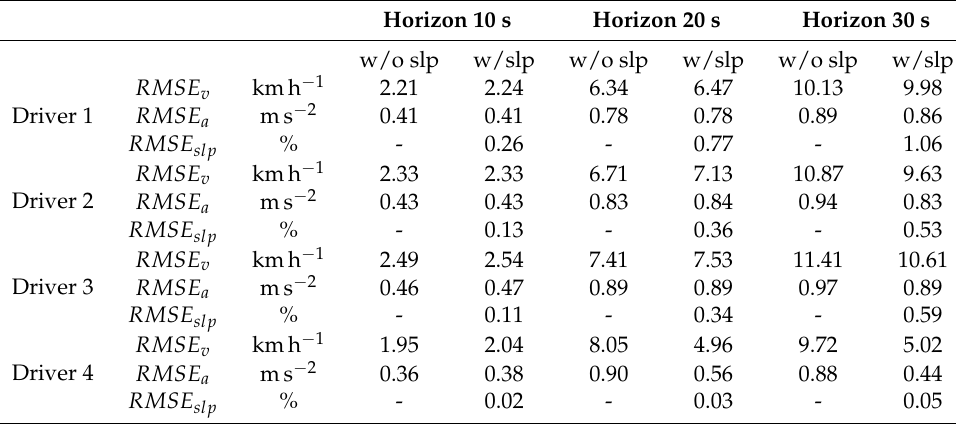
Table 6. RMSE using FNN for different prediction